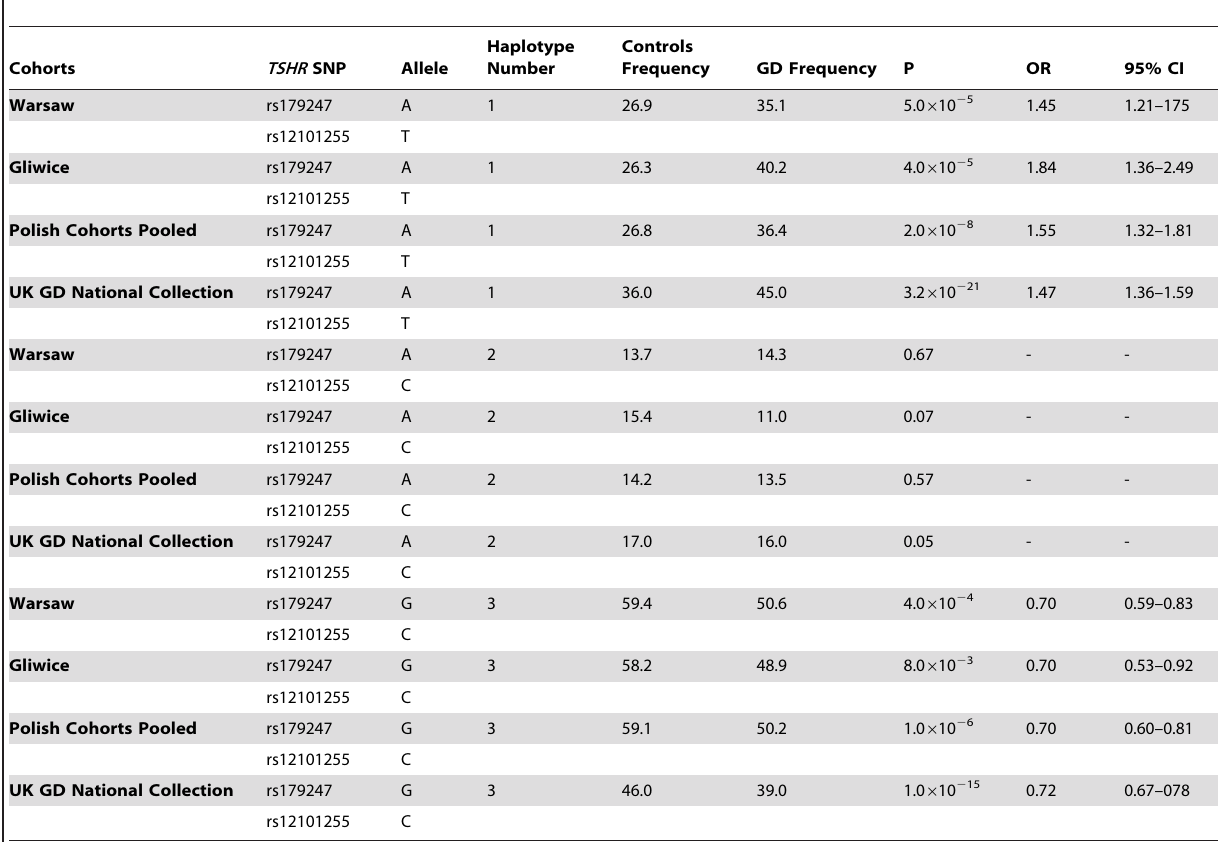
Table 2. Haplotype association tests between TSHR rs179247 and rs12101255 SNPs.